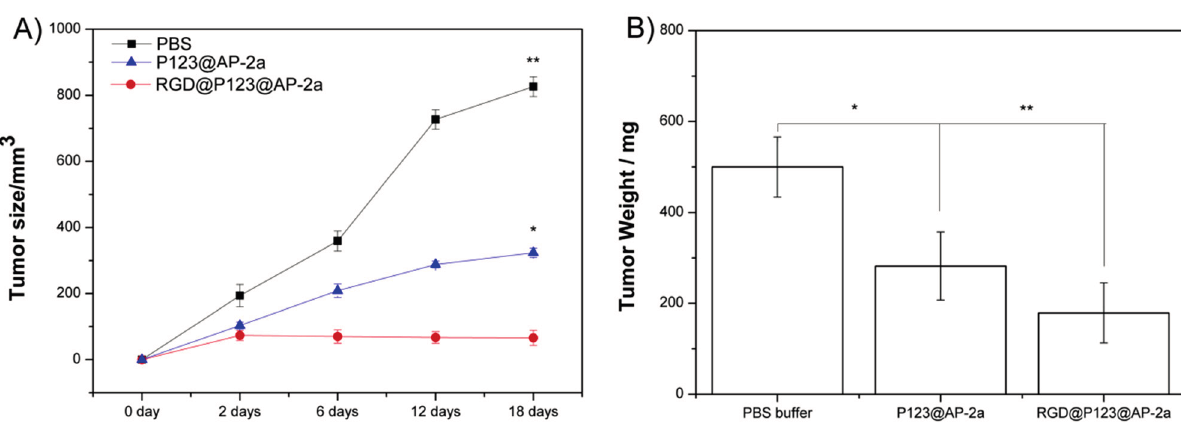
Figure 3. Western blotting analysis the changes of and other gastric cancer-associated proteins including ( A ) Bcl-2; ( B ) Caspase-3; ( C ) ErbB2; and ( D ) p21 WAF1/CIP1 in GES-1 and MGC803 after incubation with RGD@P123@AP-2 α nanocomposites, respectively. * p < 0.05.